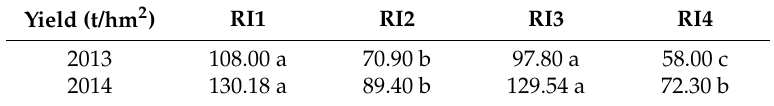
Table 6. Processing tomato yield under different fresh-saline alternating irrigation model.